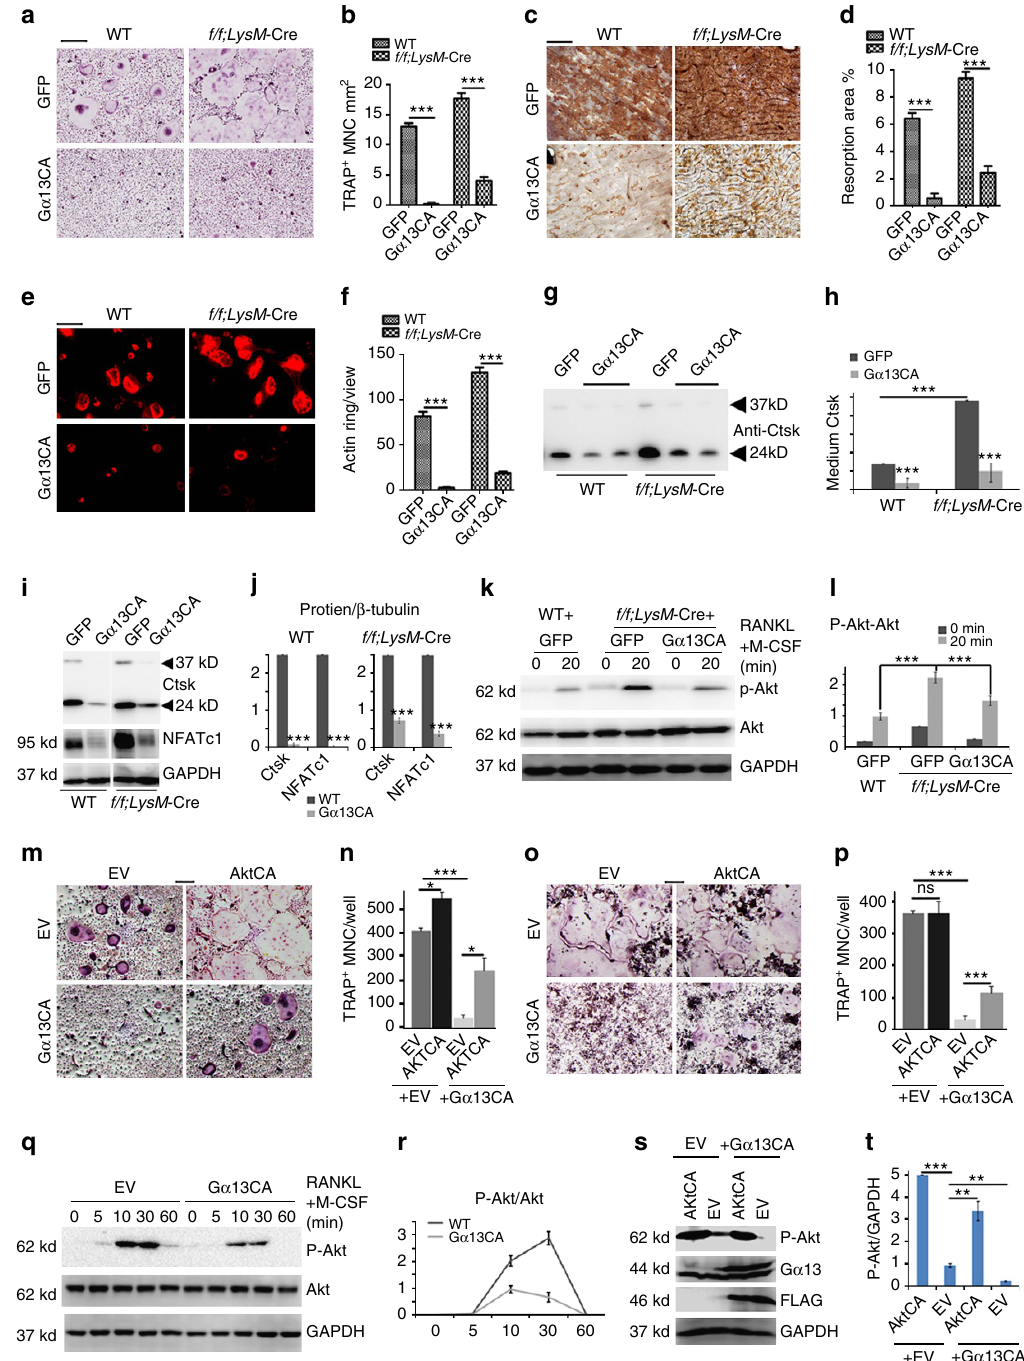
Figure 5 | G a 13 gain-of-function inhibits osteoclast formation and function in vitro . ( a ) TRAP staining to detect osteoclastogenesis of WT and